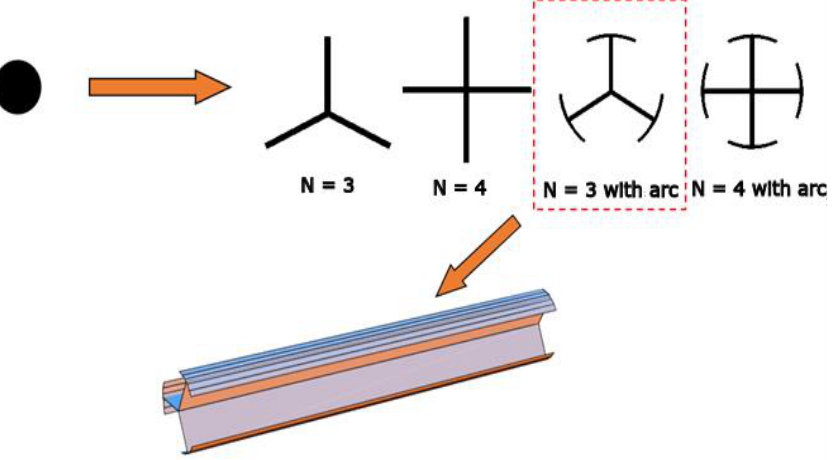
Figure 1. Redistribution of circular section to star beam and a representative flexible torsion